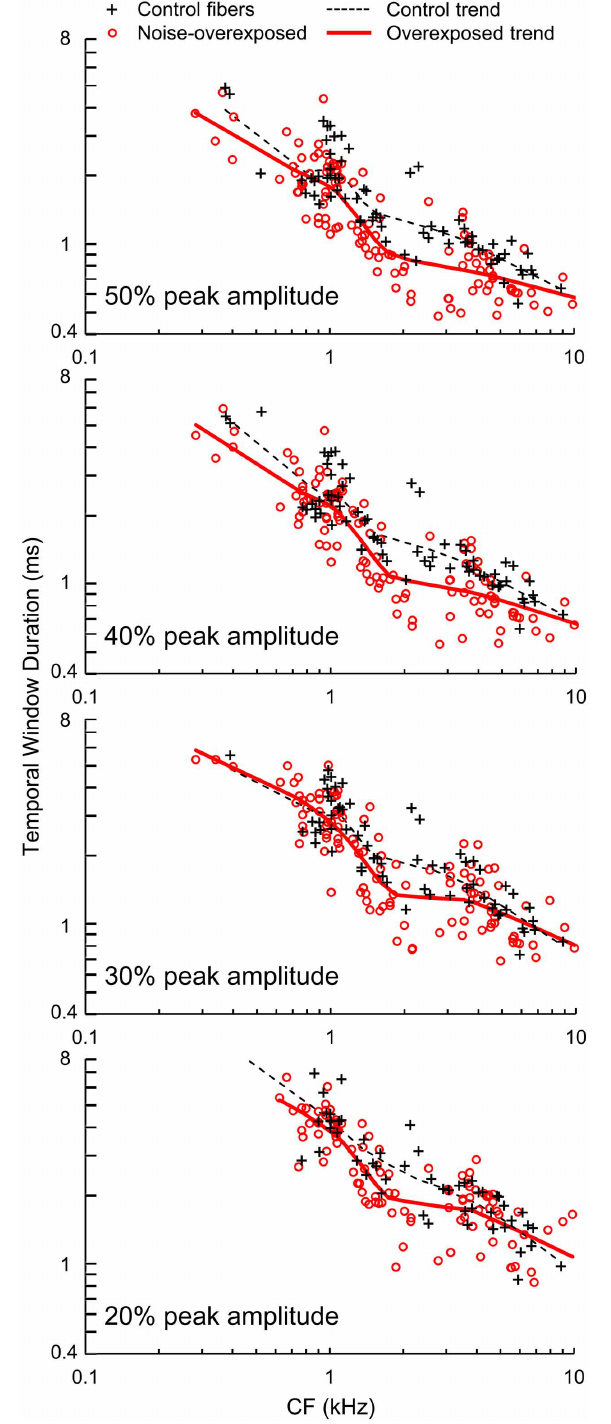
FIGURE 7 | Temporal window duration. Durations of temporal windows measured at 50, 40, 30, and 20% of peak amplitude plotted as a function of CF in normal hearing and noise-overexposed auditory-nerve fibers. Percent of peak amplitude is marked at the bottom left of each panel, and trend lines are based on local regression analyses. Temporal windows were 10–20% shorter in noise-overexposed fibers than in normal-hearing